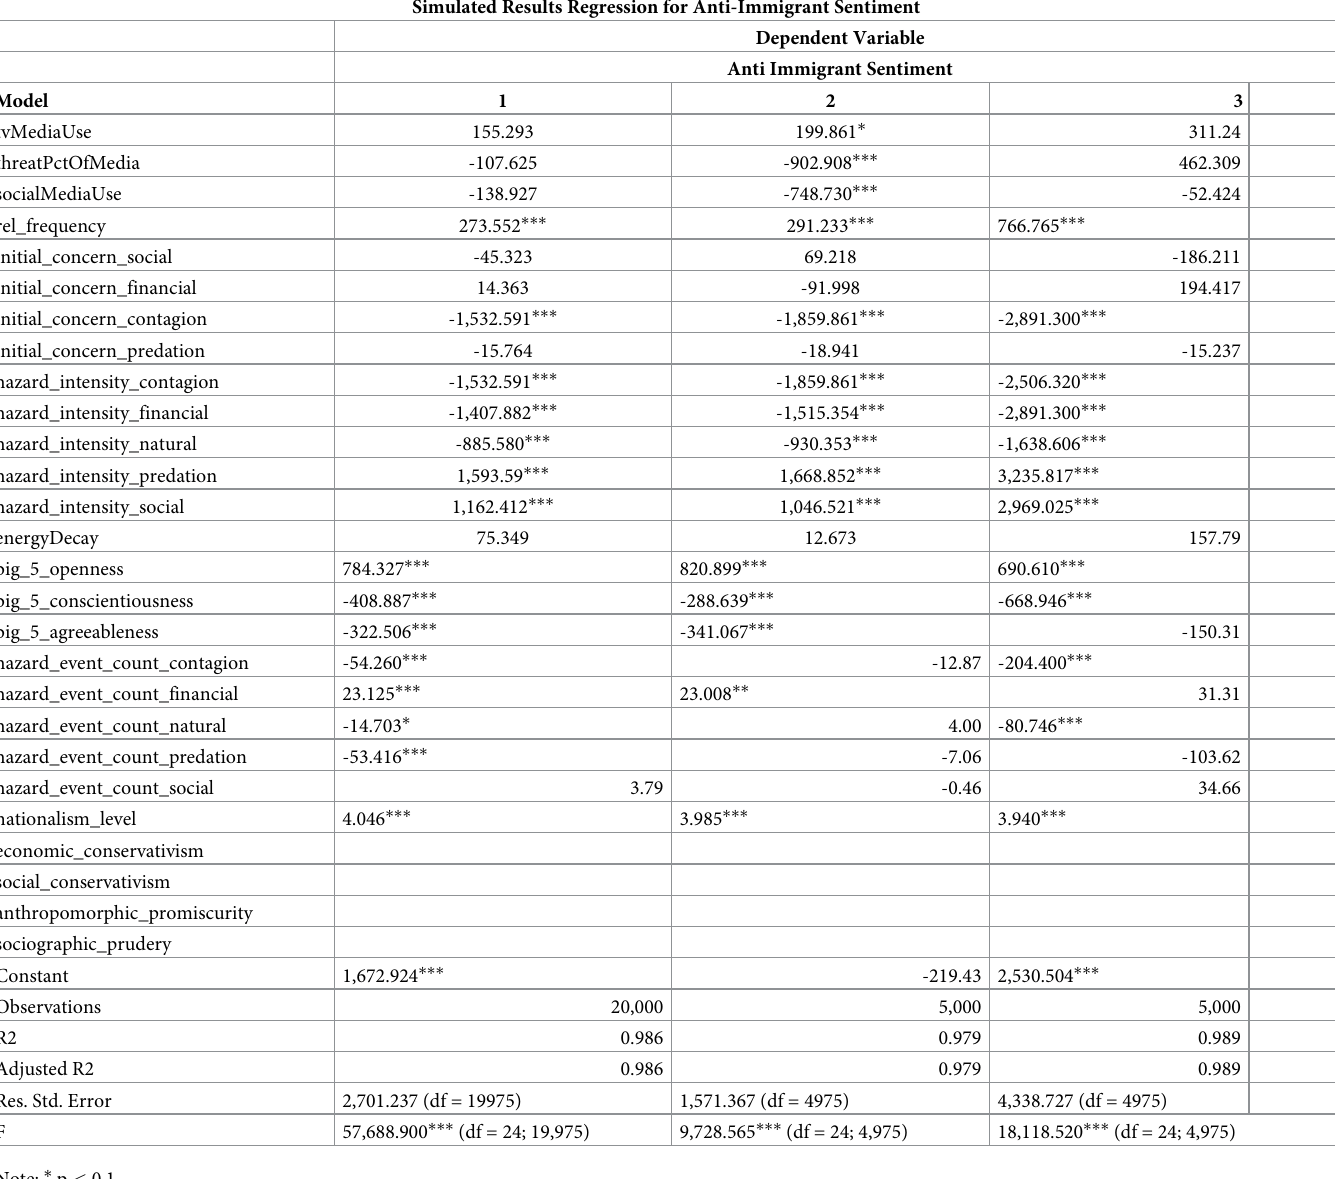
Table 9. Regression analysis of anti-immigrant sentiment as it results from other model variables. Model 1 is for all data extracted from the simulation; Model 2 uses data from simulations that only resulted in low levels of nationalism; Model 3 uses only data from those simulations resulting in high levels of nationalism. Simulated Results Regression for Anti-Immigrant